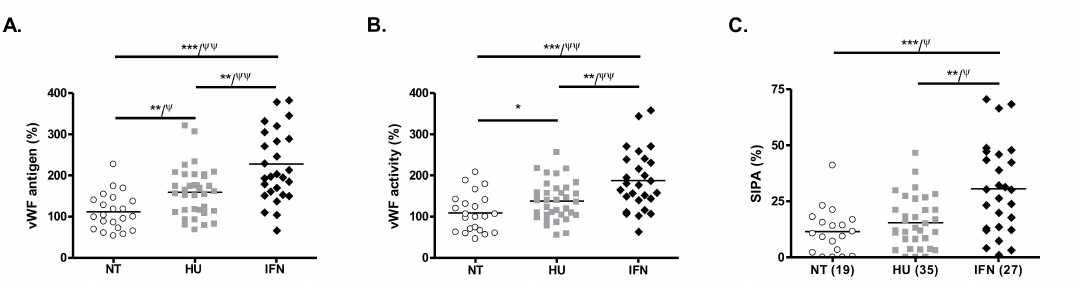
Figure 1. Von Willebrand factor antigen ( A ), von Willebrand factor activity ( B ), and platelet